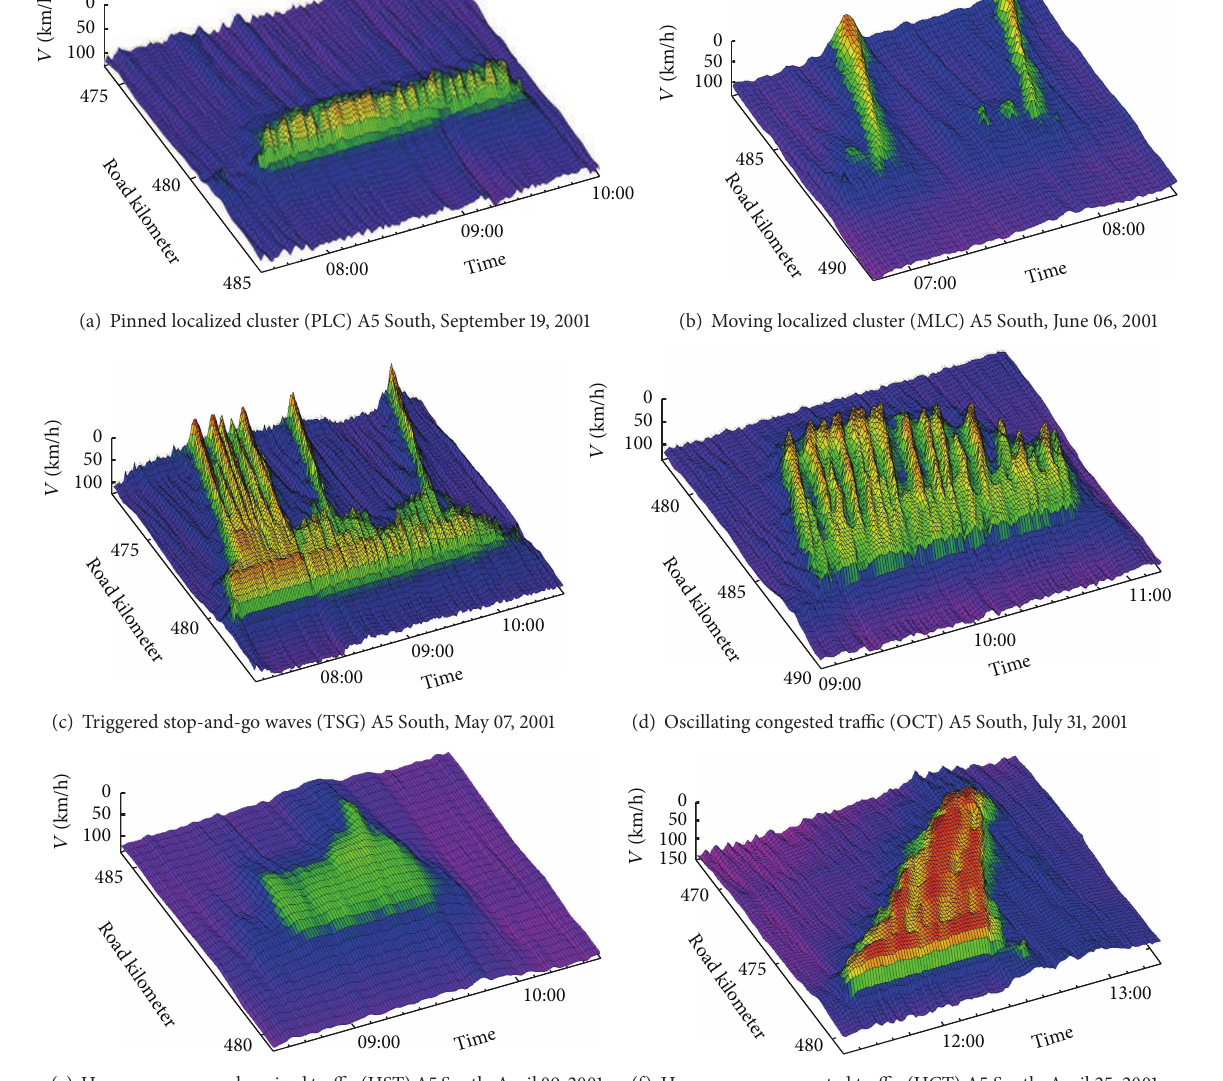
Figure 1: Examples of congested traffic states measured on the German freeway A5 close to Frankfurt. (a) Pinned localized cluster (PLC), (b) Moving localized cluster (MLC), (c) Triggered stop-and-go waves (TSG), (d) Oscillating congested traffic (OCT), (e) Homogeneous synchronized flow (HST), and (f) Homogeneous congested traffic (HCT). This figure is taken from